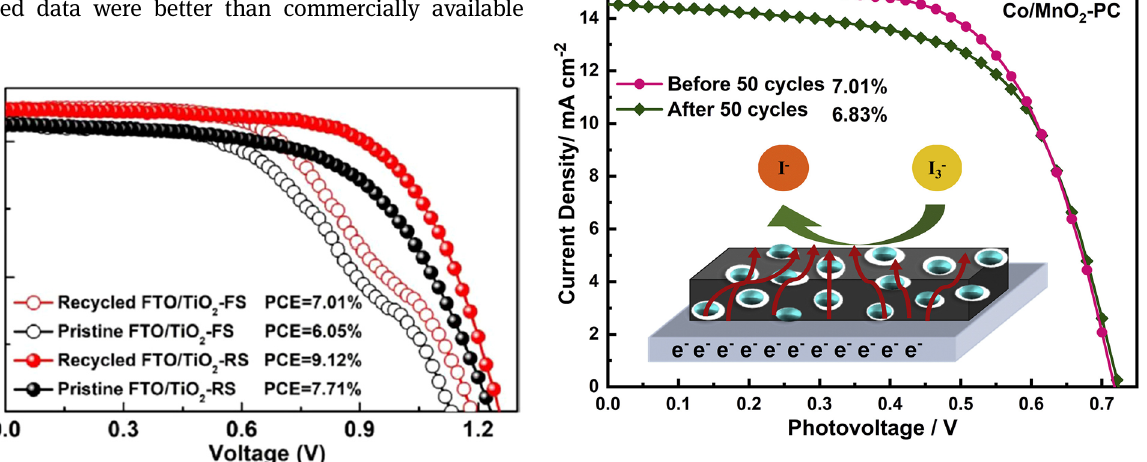
Figure 48: CsPbIBr 2 PSC performance as synthesized from recycled and pristine FTO/TiO 2 . Copied with permission from ref. [ 476 ] ; American Chemical Society, 2020.